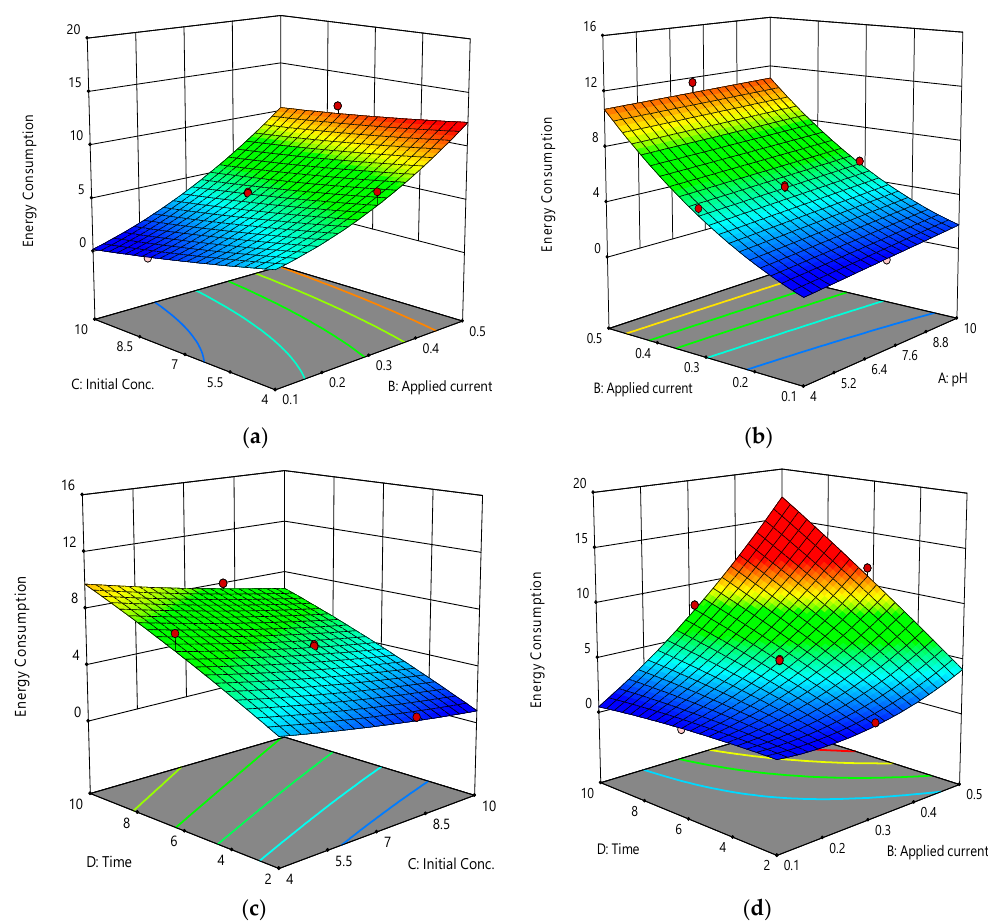
Figure 4. Surface plots in 3D presenting ( a – d ) the effect of all 4 interactive factors i.e., applied current, pH, time and initial conc. on energy consumption per gm of arsenic removed in EC process.